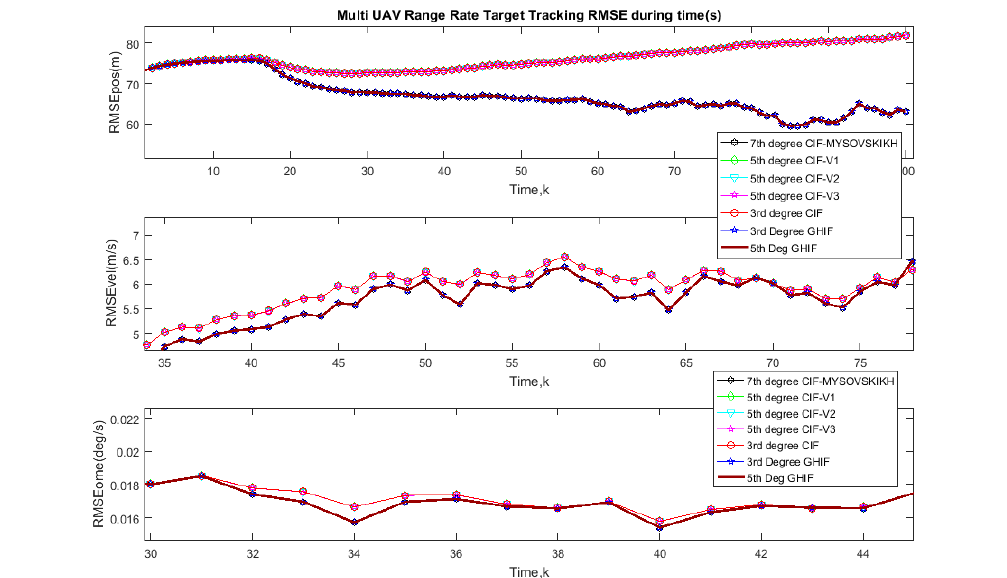
Figure 7. Root mean square error (RMSE) based on range rate Doppler: Results of 7 th -degree CIF, 5 th -degree CIF, 5 th -degree GHIF, 3 rd -degree GHIF compared to the true trajectory in green color. The lower error bound was achieved by 7 th -degree CIF and 5 th -degree GHIF.